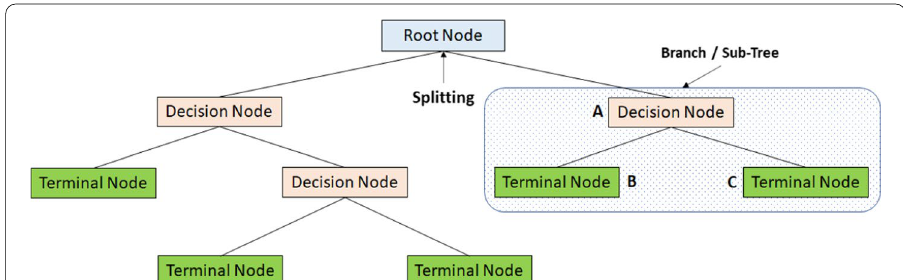
Fig. 3 Tree-based algorithms. Note A is parent node of B and C